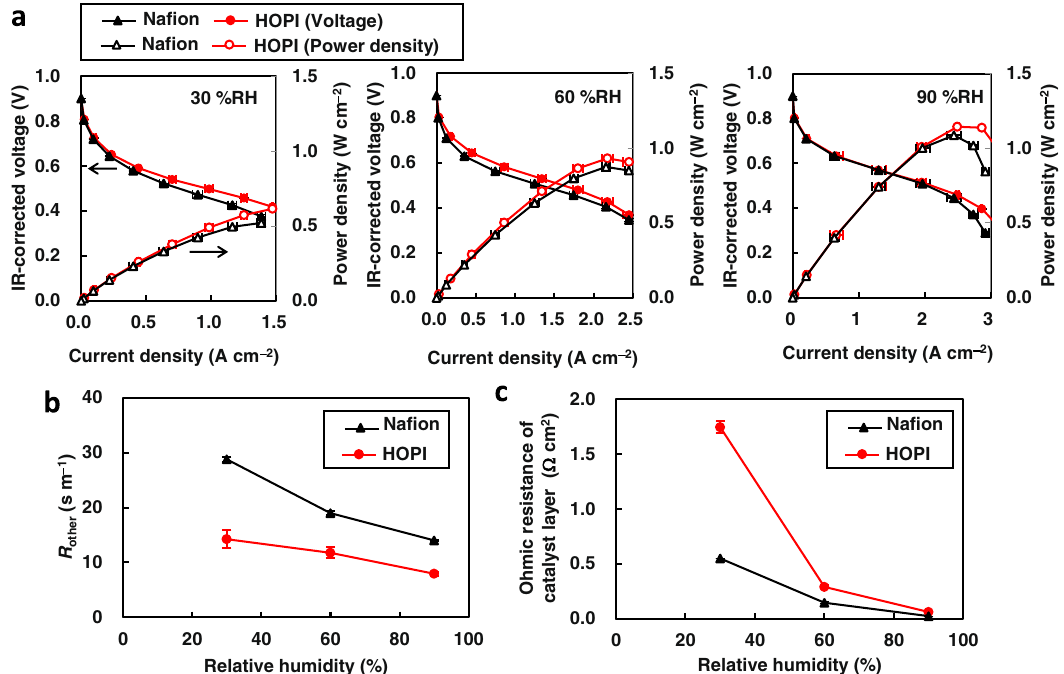
Fig. 3 Electrochemical characterizations of MEAs. a Current – voltage (with closed dots) and current – power density (with open dots) curves of MEAs with Na fi on ionomer (black) and HOPI (red) at 353 K and 30, 60, and 90% RH. b Local oxygen transport resistance R other as a function of RH. c Ohmic resistance of CLs in MEAs. All measurements were conducted twice, and the differences between two measurements were shown as error bars in all fi gures.